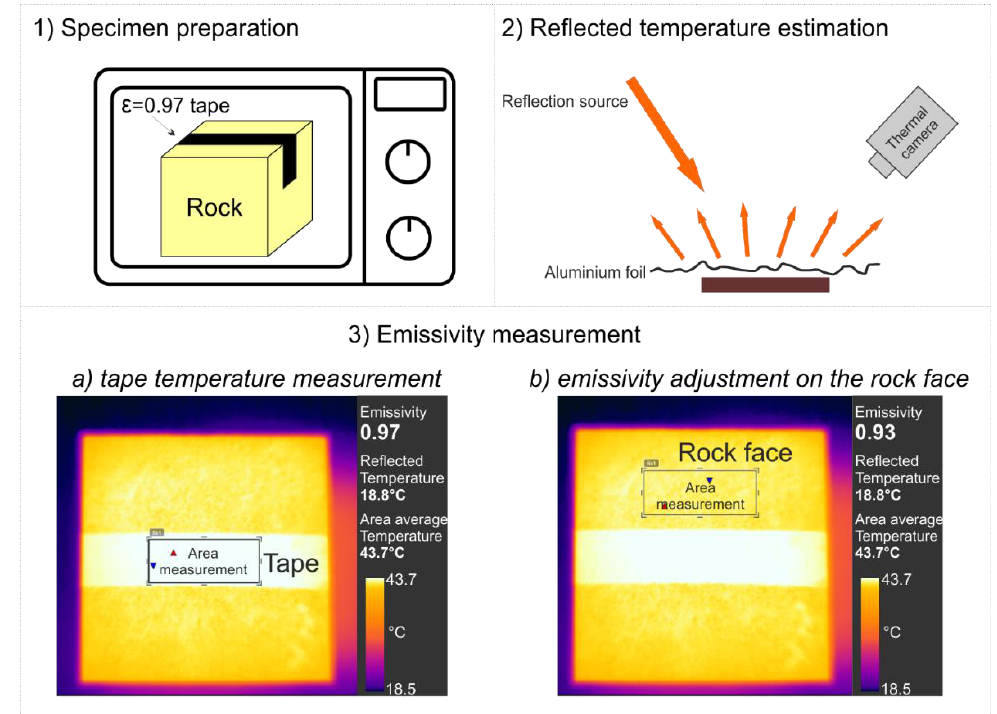
Figure 3. Phases of the methodological approach carried out to determine the emissivity of rock specimens. Sketch in inset (2) is modified from [20].